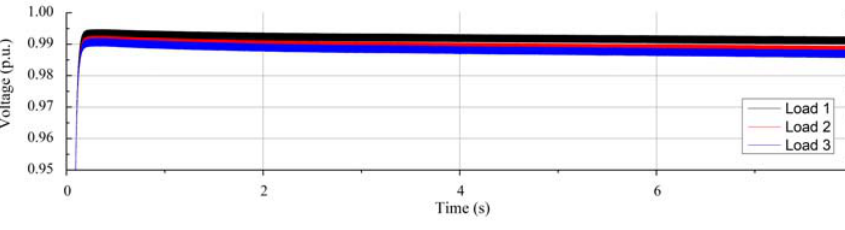
Table 3. Simulated case study description. Simulation Time